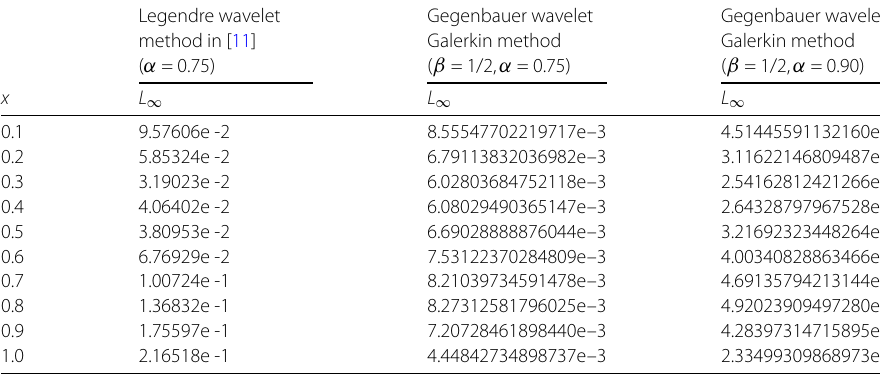
Table 4 Comparison of L ∞ errors of Example 1, for various values of x Legendre wavelet method in [11]